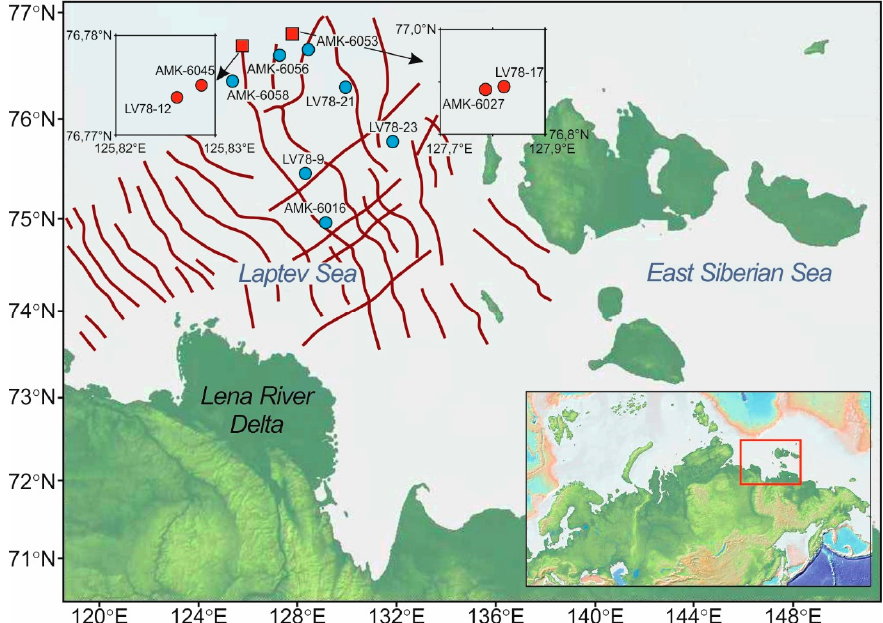
Figure 1. Map showing the locations of the sampling site (the Laptev Sea). The red circle symbol represents stations at which methane seeps were registered. Red lines show the faults of the Laptev Sea Rift System according to Baranov et al. [35] and Sekretov [37].